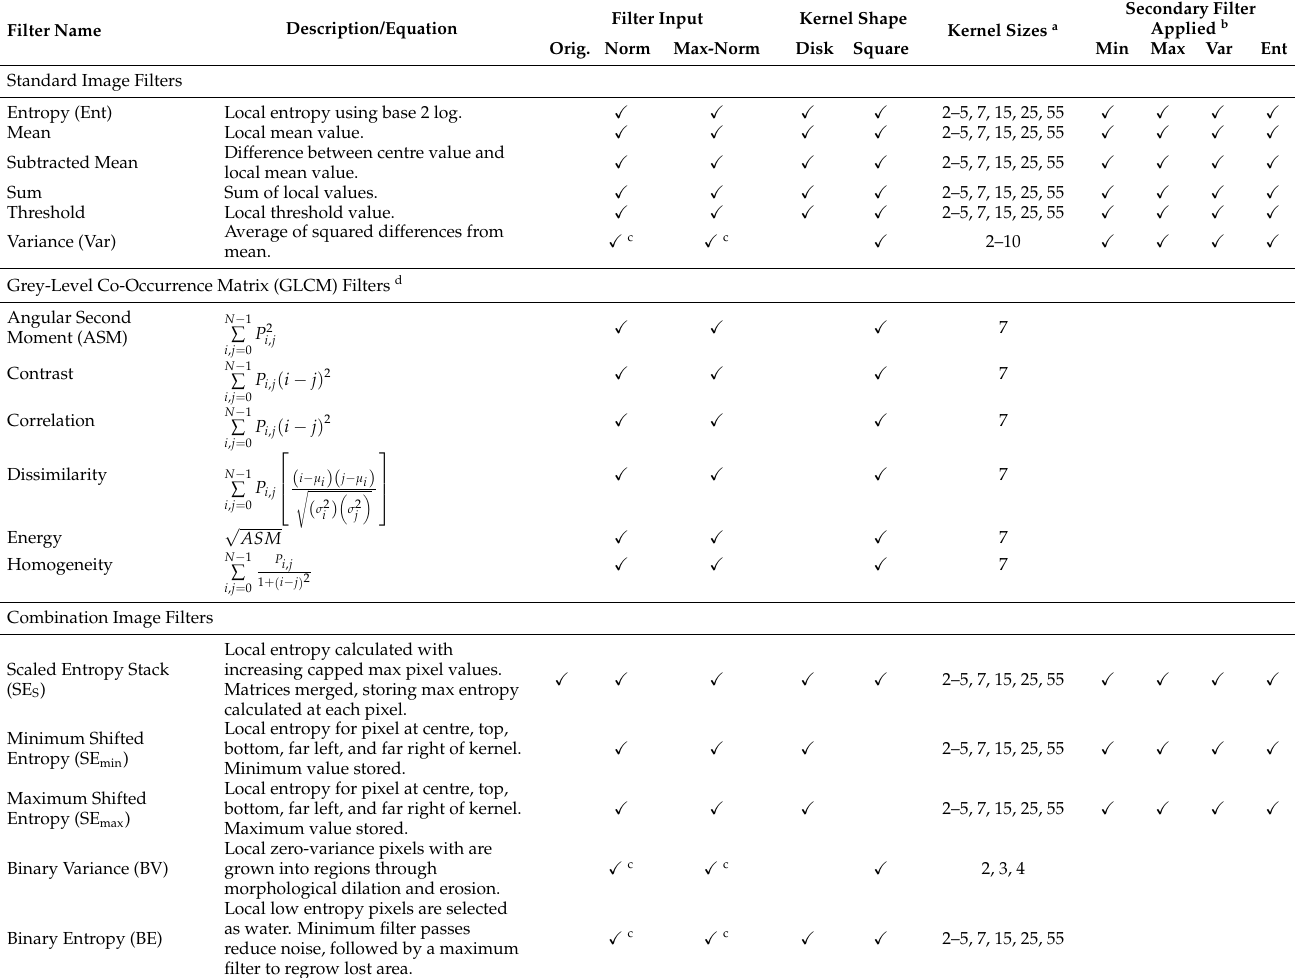
Table 1. Image filters and variants tested for RF feature